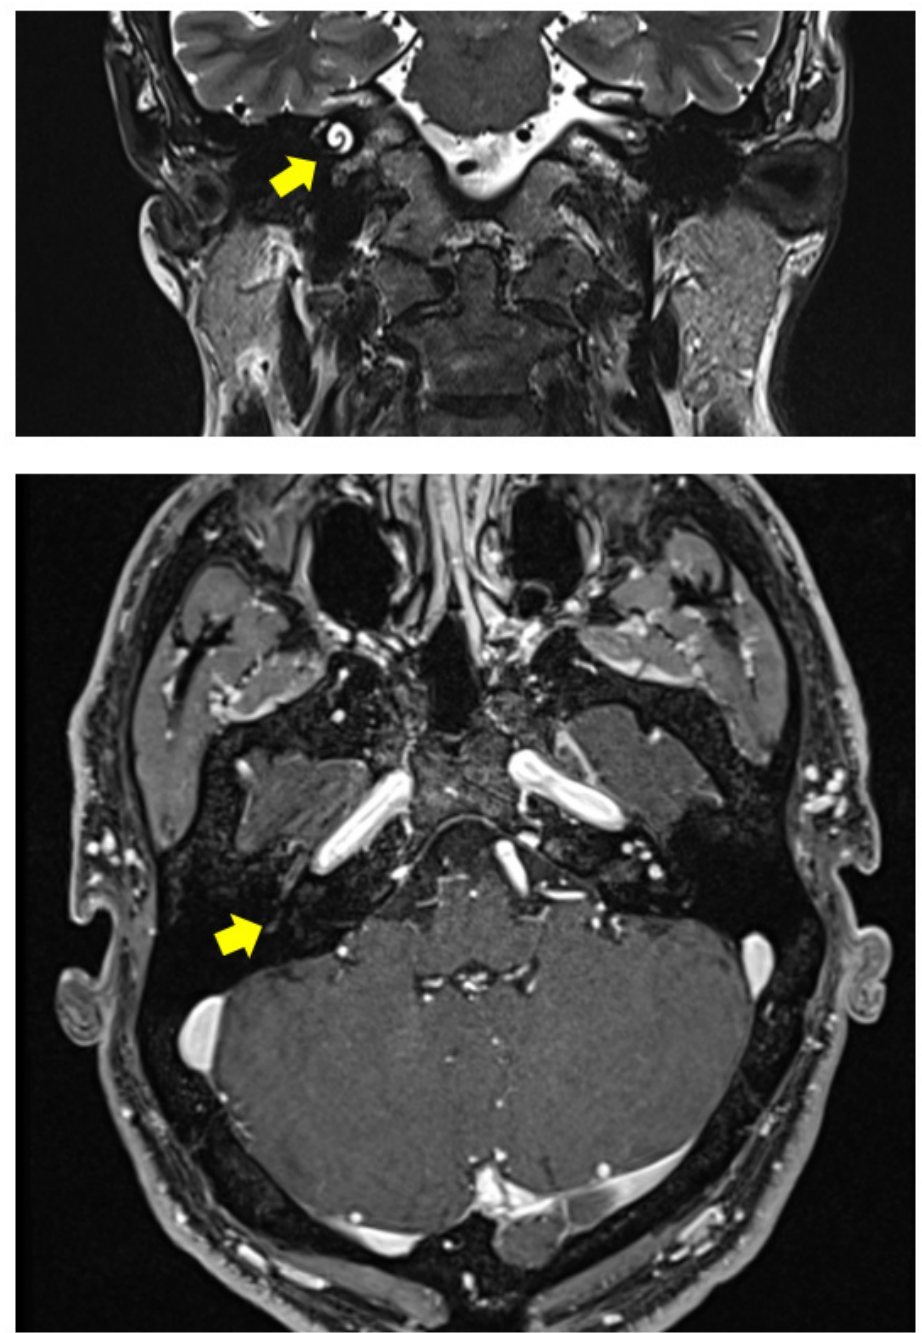
Figure 1. Clinical Case 1: 3 Tesla MRI with gadolinium showing an ILS filling the right cochlea with initial vestibular involvement.